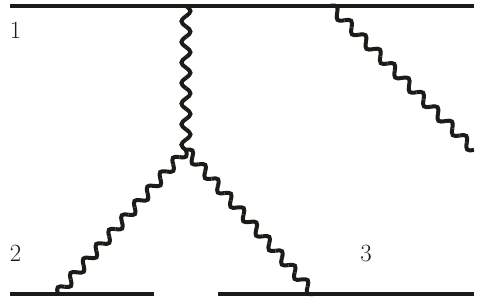
Figure 3 . A schematic diagram which is zero is YM but non-zero in (dilaton) gravity. The conventions follow (cid:12)gure 2 but the wavy lines are gauge (cid:12)elds in YM, or gravitons in gravity. Particle 1 absorbs the leading-order radiation from 2 and 3 before emitting the (cid:12)nal radiation. The corresponding color factor is zero by antisymmetry of the structure constant once we identify the color c 3 with c 2 , following the prescription eq. (3.1). The corresponding diagram is non-zero for